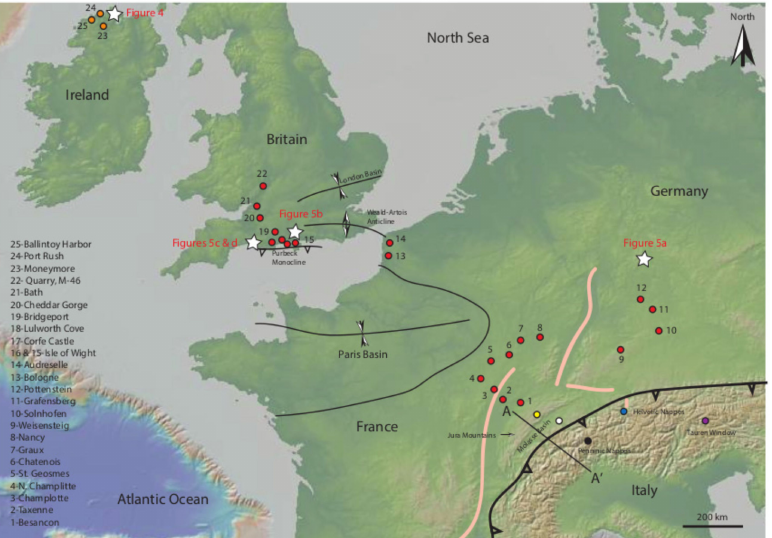
Figure 1. Topographic map of western Europe with regional geologic features related to Alps and the Alpine foreland, including extensional features of the European Central Rift System (ECRIS). Sample sites are listed (left column; red dots, for the foreland, the Alps (many colors, see Figures 2 and 3) and the Irish Coast (orange dots). Locations of field photos in additional figures are indicated by white